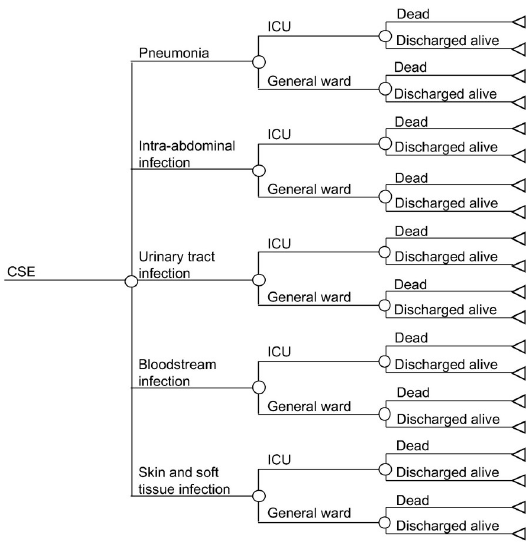
Fig 2. Tree diagram for carbapenem-susceptible Enterobacterales